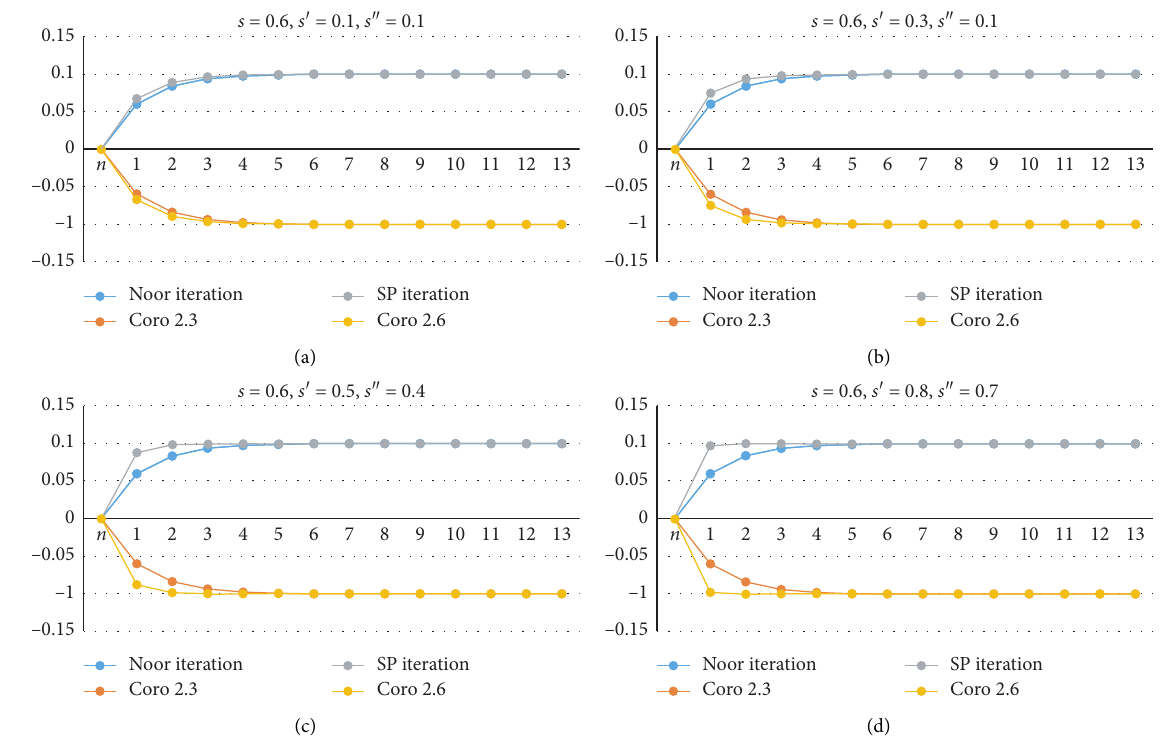
Figure 2: (a–d) Graphs of biquadratic functions given in Tables 5–8,